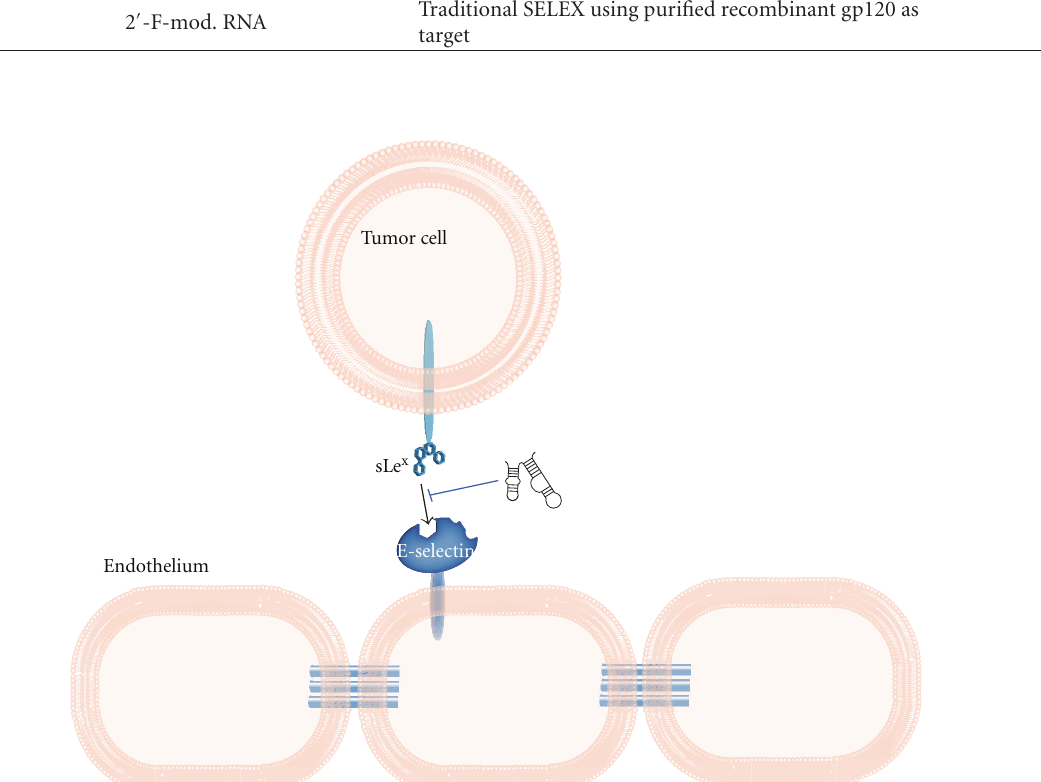
bound to di ff erent cell types presenting RET on their cell surface. The aptamer interfered with ligand-induced receptor dimerization or dimerization caused by activating mutations within the receptor, and thereby inhibiting intracellular RET signaling